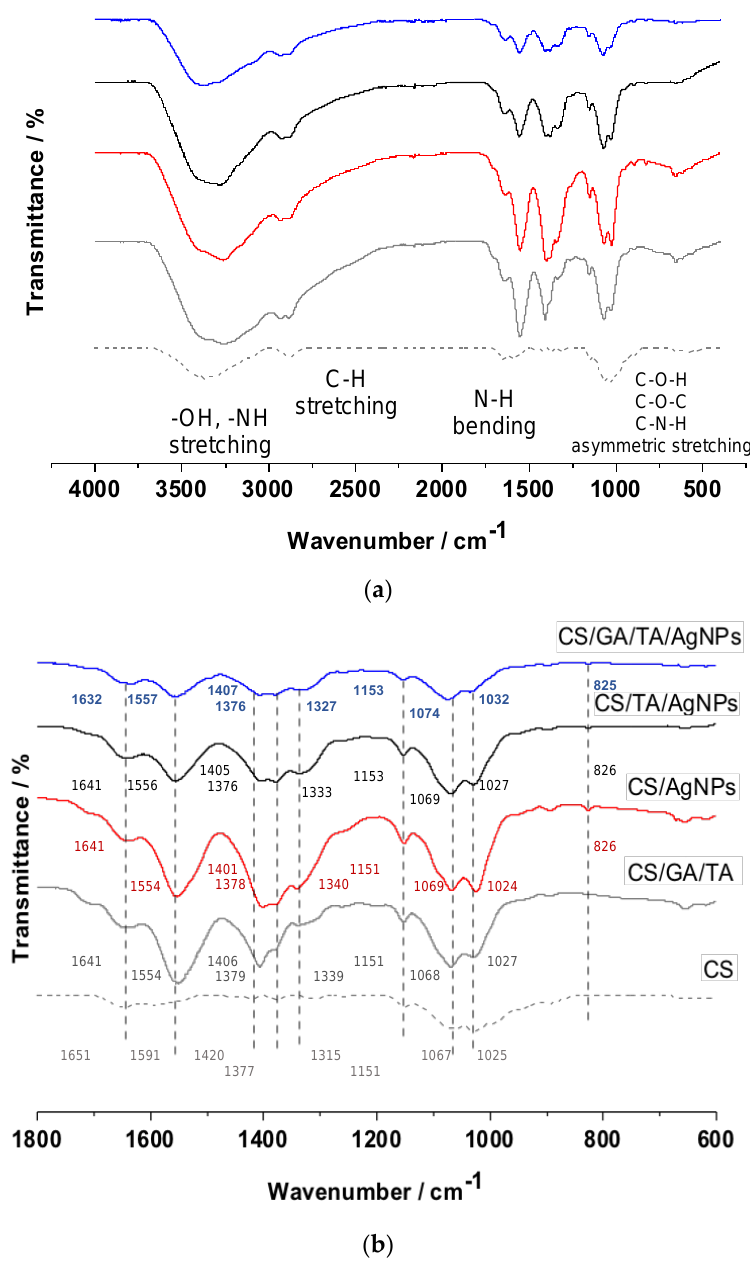
Figure 4. FTIR analysis of individual components and composites of different compositions: ( a ) full spectra with the highlighted regions of interest, ( b ) detailed spectra in the fingerprint region with highlighted changes in the positions of the peak and relative intensities. Dashed grey corresponds to CS (1), grey to CS/GA/TA (3), red to CS/AgNPs (1-Ag), black to CS/TA/AgNPs (2-Ag) and blue to CS/GA/TA/AgNPs (3-Ag).